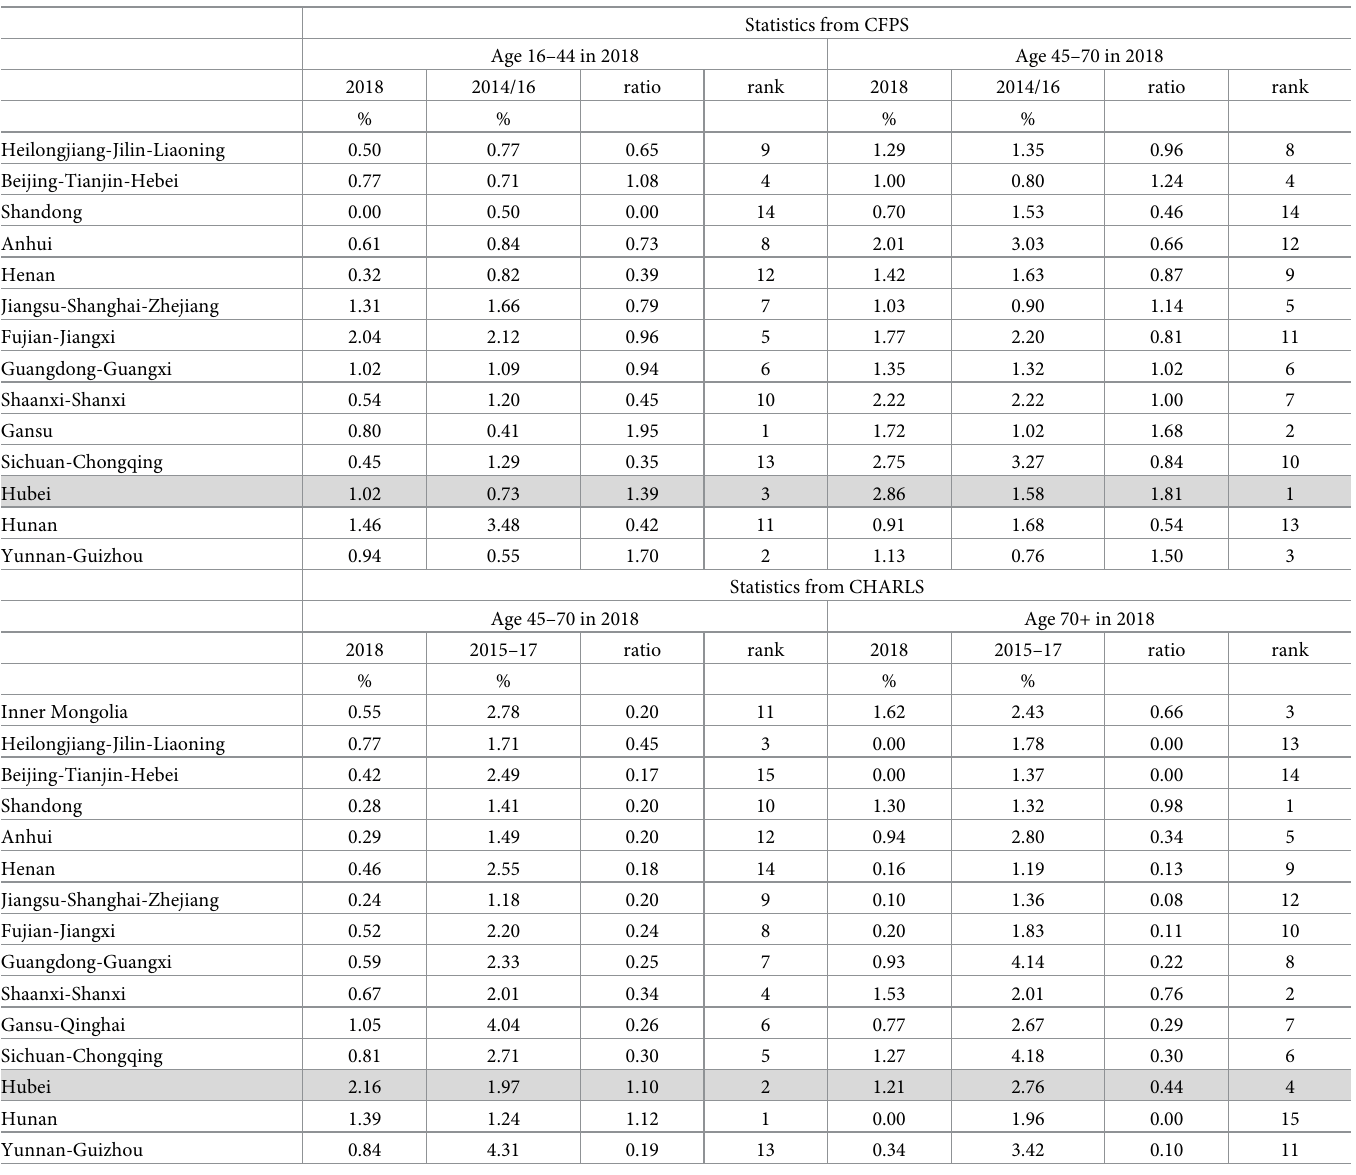
Table 7. Diagnosis of lung disease by